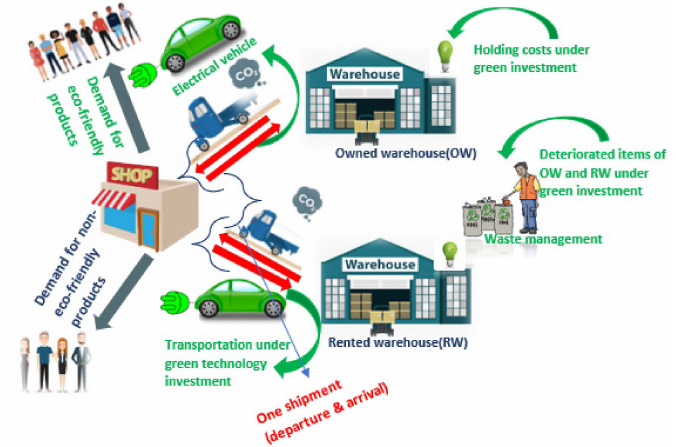
Figure 5. Warehouse inventory system under a green